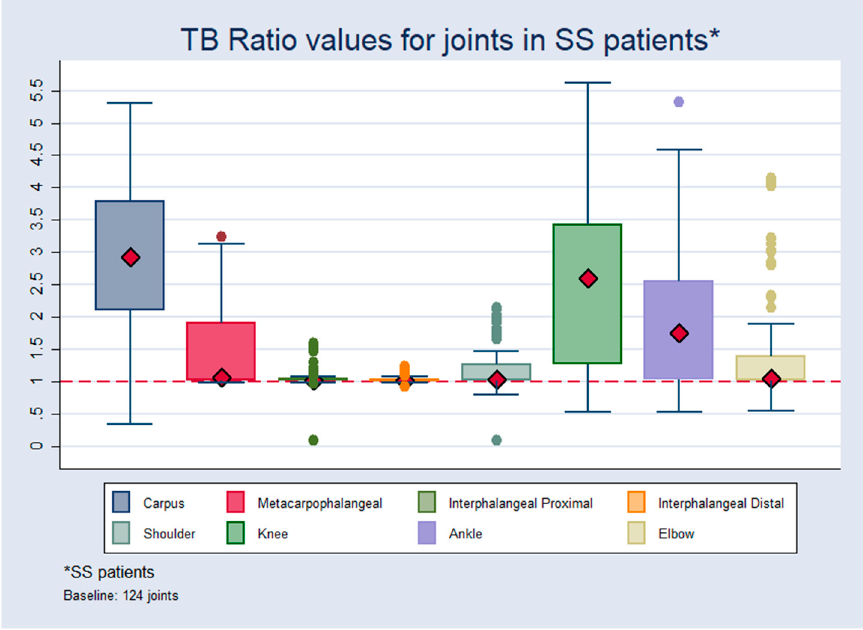
Figure 2. TBR values for joints in patients with SS.